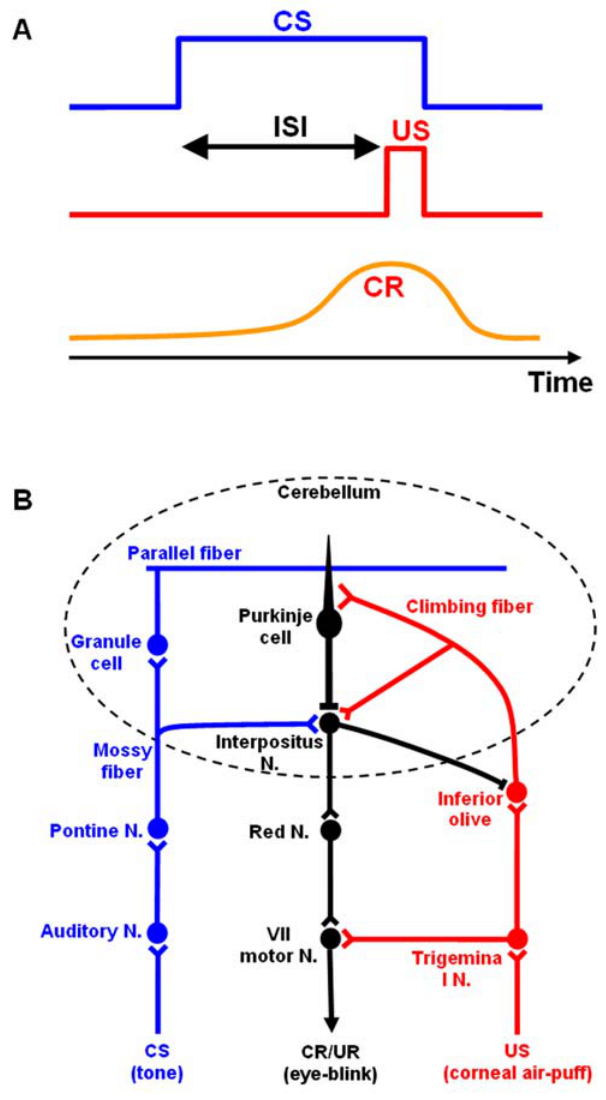
Figure 1. Classical delay eyeblink conditioning. A. conditioned stimulus (CS) and unconditioned stimulus (US) timing in delay conditioning. The inter-stimulus interval (ISI) is the time interval between the beginning of the CS and the beginning of the US. CS and US co-terminate. B. Pathways for classical delay eyeblink conditioning. The cerebellum receives CS and US signals during learning, resulting in an eye blink (the unconditioned response, UR). After learning, the cerebellum generates a delayed conditioned response (CR) to the CS that occurs just before the arrival of the expected